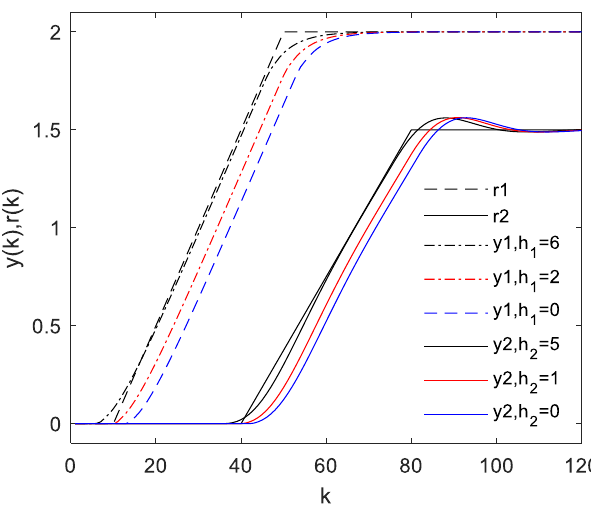
Figure 5. The output response of System (1) θ 1 = 1.